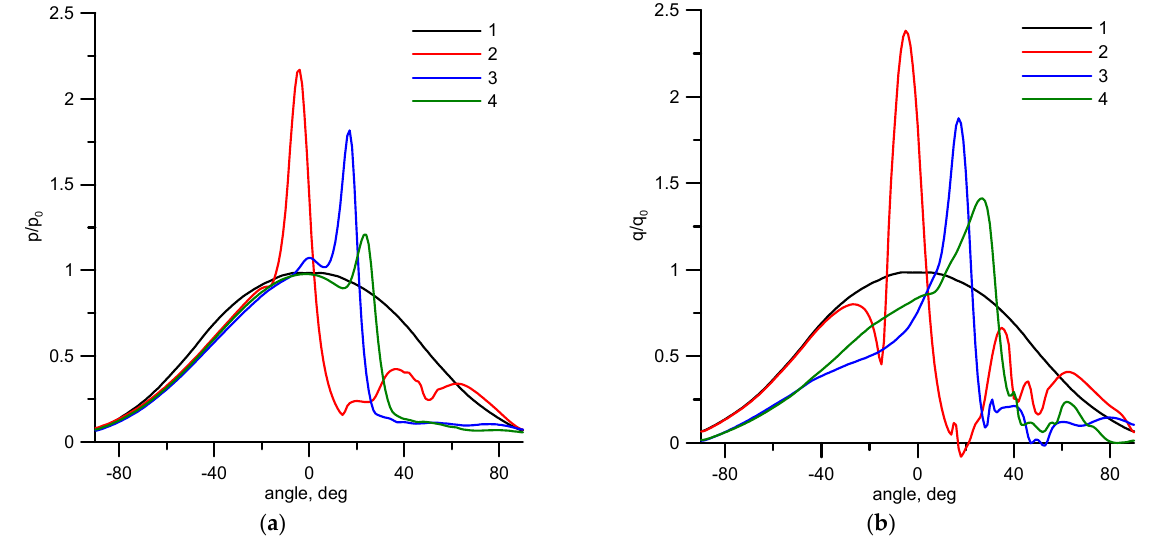
Figure 5. Distributions of pressures ( a ) and heat fluxes ( b ) along the surface at successive times for the variant with one particle. 1—initial moment, 2—0.3 ms, 3—0.53 ms, 4—0.63 ms.